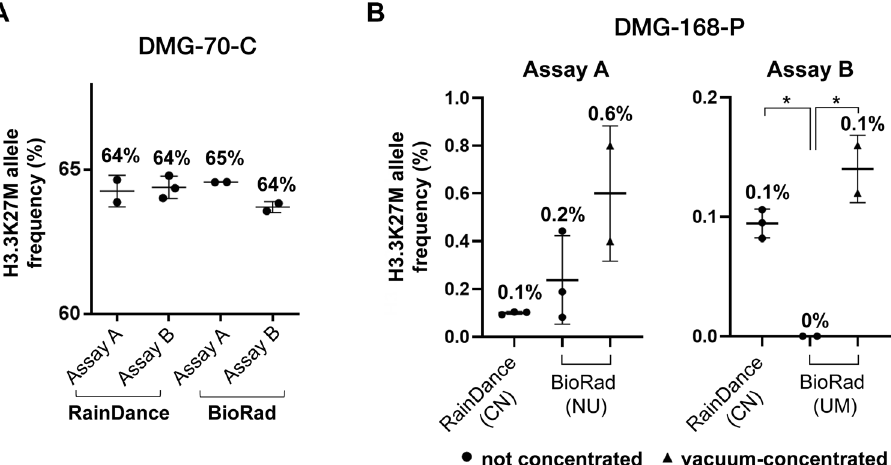
Figure 2. Optimization of ctDNA detection across technical platforms and institutions. ctDNA extracted from CSF (DMG-70-C) and plasma (DMG-168-P) samples were analyzed for H3K27M mutation on BioRad and RainDance platforms at multiple institutions (CN, NU, UM). ( A ) CSF-derived ctDNA ddPCR results. CSF-derived ctDNA was pre-amplified at CN prior to ddPCR analysis. A 12 µL of sample was analyzed on the RainDance platform (CN), and 1 µL analyzed on the BioRad platform (UM). Fewer positive droplets were detected on the BioRad compared to the RainDance platform, while MAF remained similar across platforms and institutions. ( B ) Plasma-derived ctDNA analysis. Plasma-derived ctDNA was pre-amplified at CN via conventional PCR, using Assay A (right) and Assay B (left) primer/probe sets, prior to ddPCR analysis with Assay A across institutions. Speed vacuum concentration of samples was necessary to ensure preservation of input DNA in the requisite smaller sample input volume for the BioRad instrument. Superior test sensitivity * = Statistically significant difference in MAF (t-test , p <